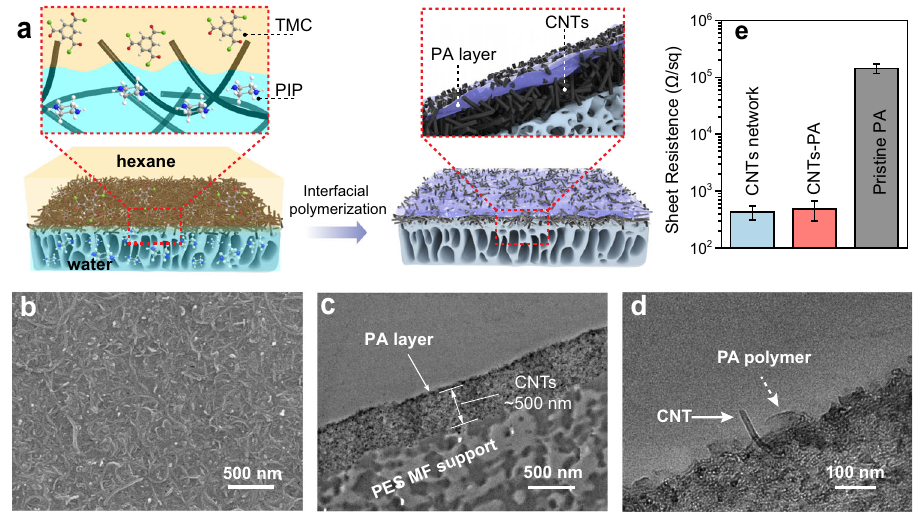
Fig. 2 | Fabrication, structure, and electricalresistance ofCNTs-PA membrane. a Schematic illustration of the approach for fabricating electrically conductive CNTs-PAmembrane. b Top-viewSEMimageof theCNTs-PAmembrane. c , d Cross- sectionalTEMimagesoftheCNTs-PAmembrane. e SheetresistancesofthePA-free